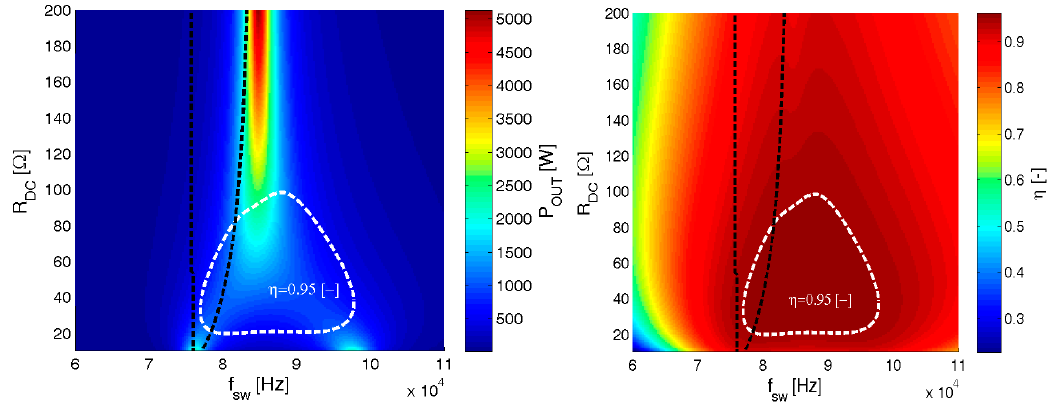
Figure 3. Power delivered to the load ( left ) and overall efficiency ( right )—working distance 20 cm.